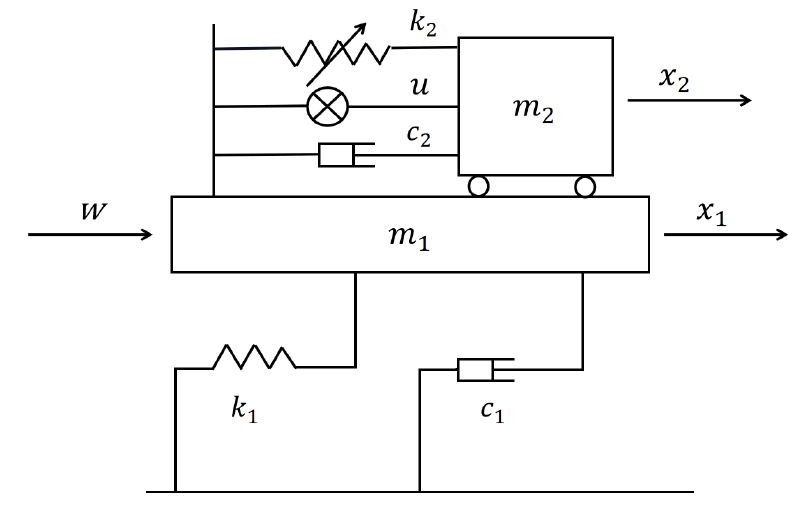
Figure 1. An NES-based offshore